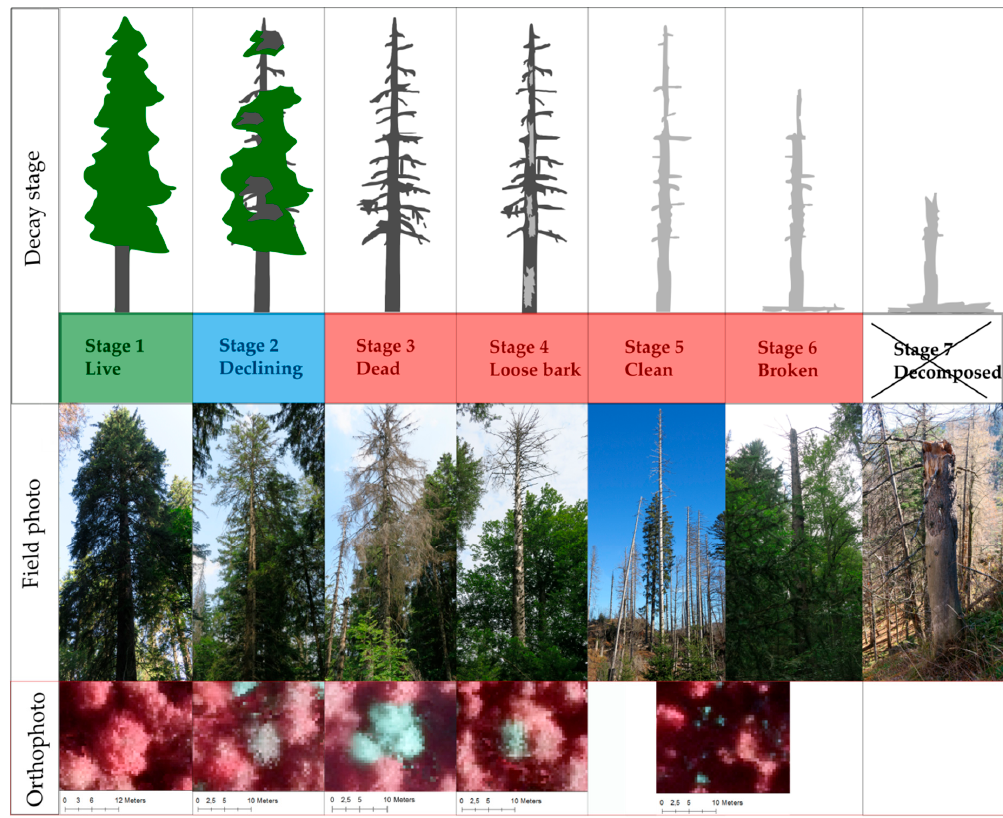
Figure 2. Classification of forest trees in three model classes (“live”–green, “declining”–blue, “dead”–red), the corresponding decay stages as adapted from Thomas et al. [61] in Zielewska-Büttner et al. [16], as well as their appearance photographed in the field (field photo) and from the air (orthophoto). Low snags and stumps (h < 5 m) were excluded from the study. To exclude low stumps and avoid misclassifications with visible bare ground or lying deadwood, only pixels of 5 m or above in height according to the CHM were selected for the analysis. Considering the advantages of the infrared band in depicting differences in cell structure and water content in the vegetation, we did not only distinguish between “dead” and “live” (vital) vegetation but considered “declining” trees with signs of dieback, breakage, or foliage discoloration. A fourth class, “bare ground”, was included in the model to account for pixels where the CHM was not accurate enough to exclude bare ground areas.